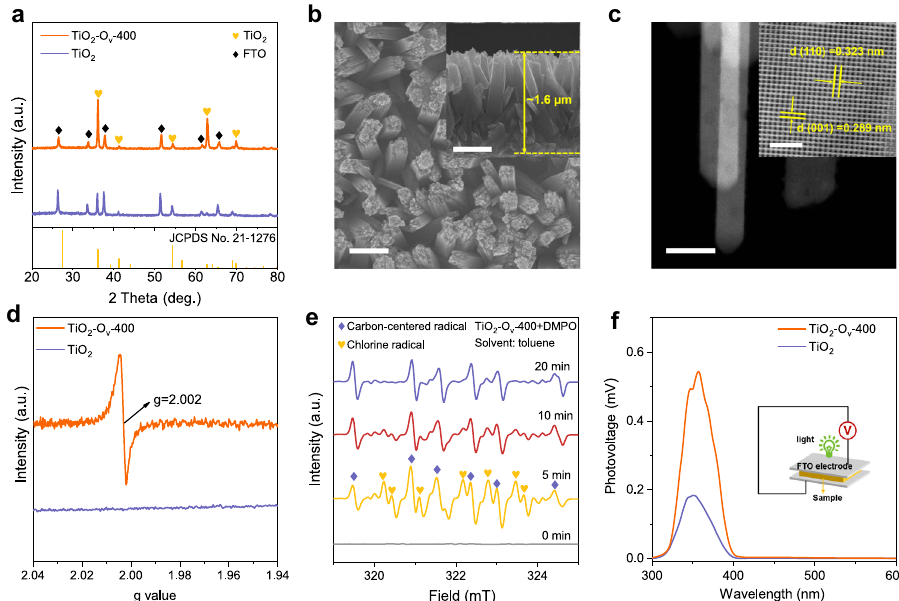
Fig. 4 Structural characterisations and photoelectric properties of TiO 2 -O v -400 photoanode. a XRD patterns of TiO 2 and TiO 2 -O v -400. b SEM images of TiO 2 -O v -400. Scale bars: 200 nm (inset). c HAADF-STEM images of the TiO 2 -O v -400. Scale bars: 200 nm, 2 nm (inset). d Room temperature EPR spectra of TiO 2 and TiO 2 -O v -400. e EPR spectrum detected from the photolysis of TiO 2 -O v -400 after immersing in 0.5 M NaCl under AM 1.5G (100 mW cm − 2 ) illumination in toluene solution containing DMPO as spin-trapping agent. f Steady-state SPV spectra of TiO 2 and TiO 2 -O v -400 photoanodes. The inset shows the schematic of the photovoltaic cell structure. a.u.: arbitrary